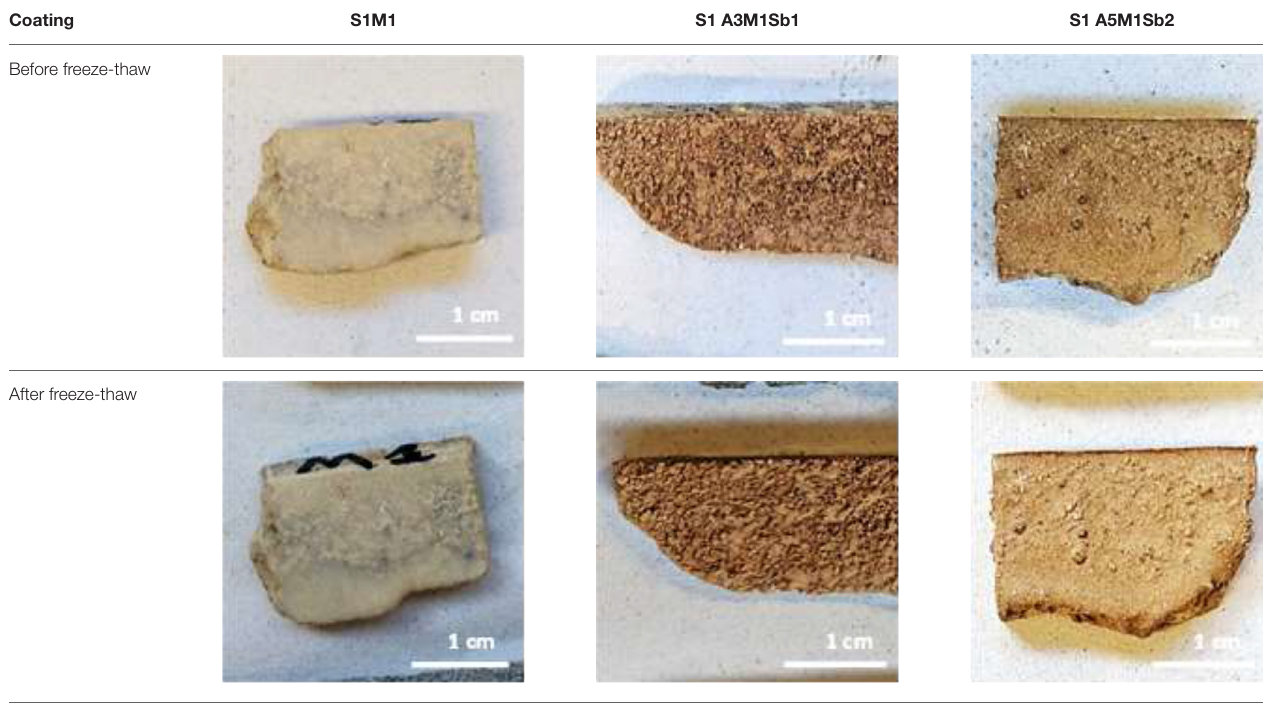
TABLE 6 | Picture of coated Fez stone before and after 20 freeze-thaw cycles. Coating